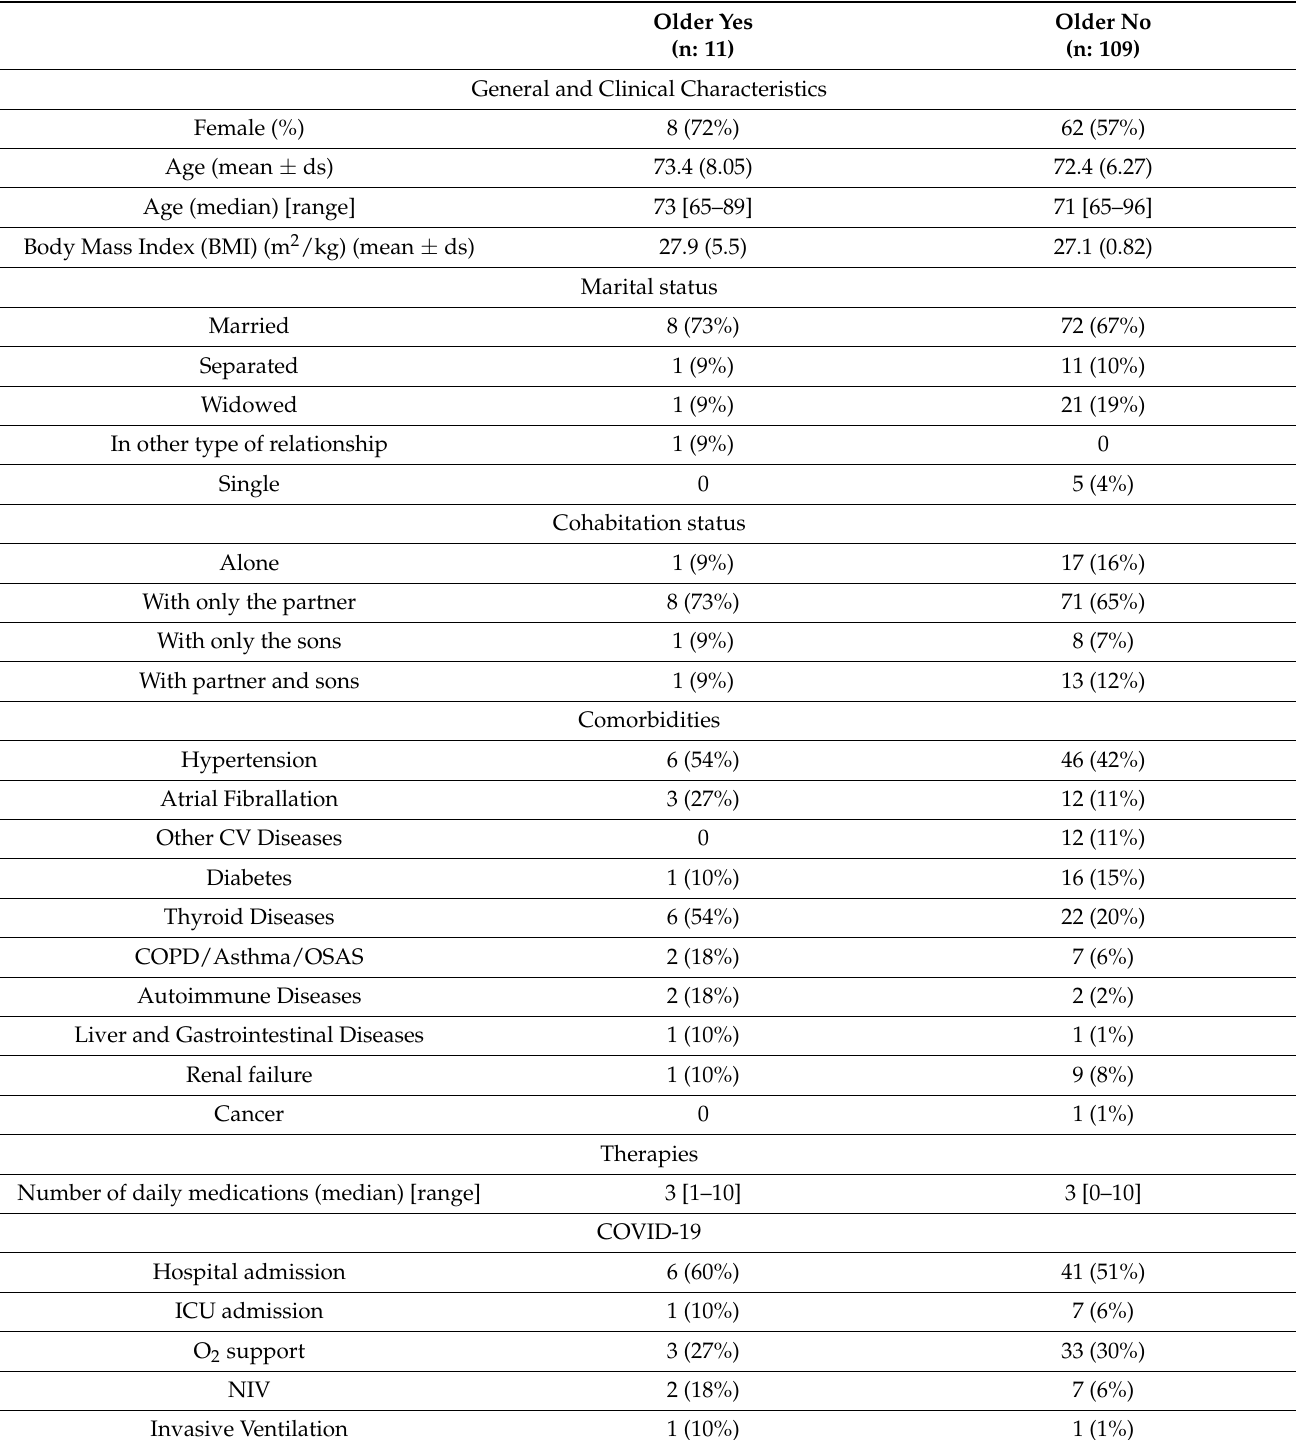
Table 3. Characteristics of older subjects according to the need to continue analgesic therapy in the post-acute COVID-19 (YES: those who continued taking analgesics in the post-acute phase; NO: those who did